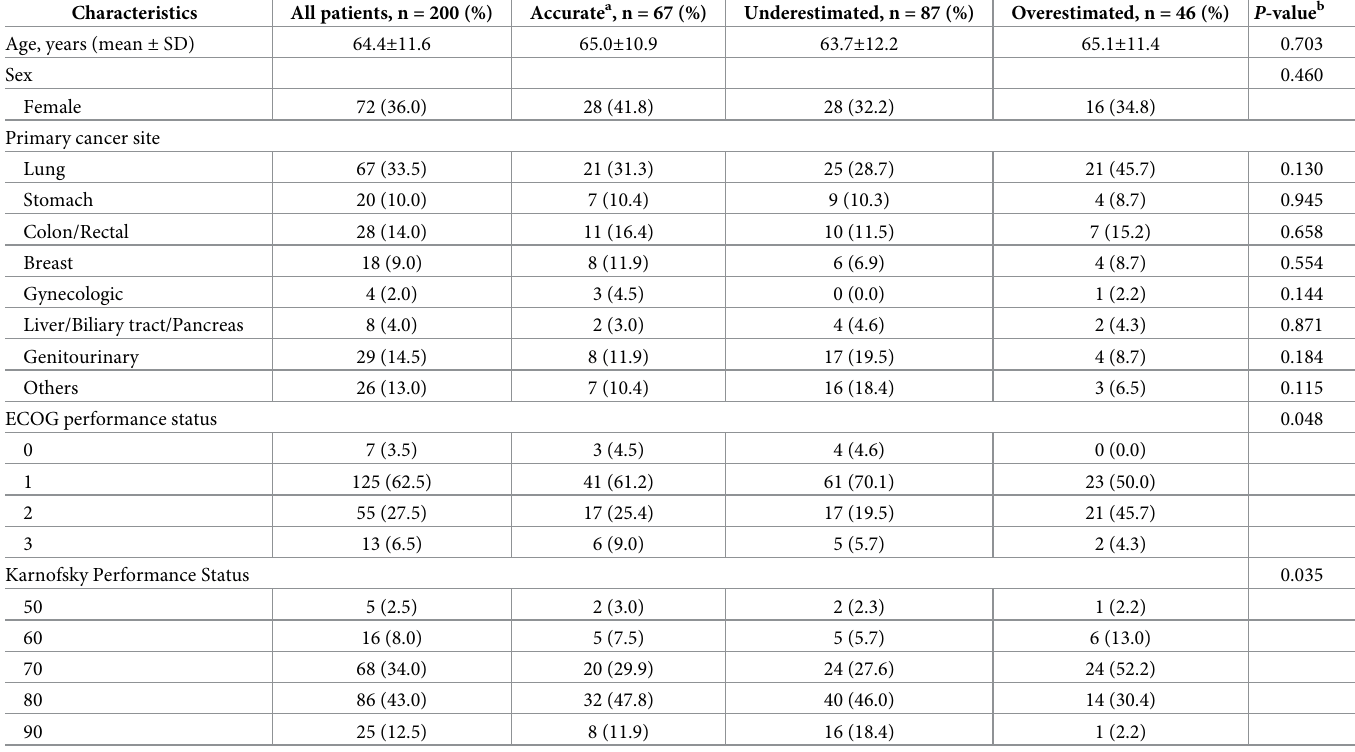
Table 1. Baseline patient characteristics (n = 200).